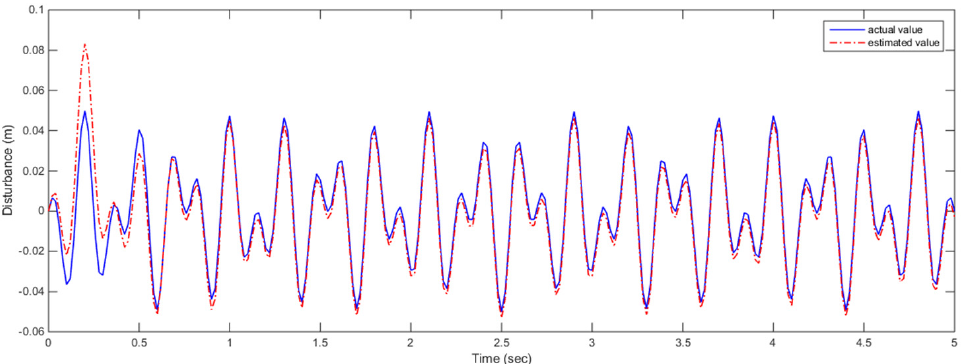
Figure 7. The disturbance and its estimation.